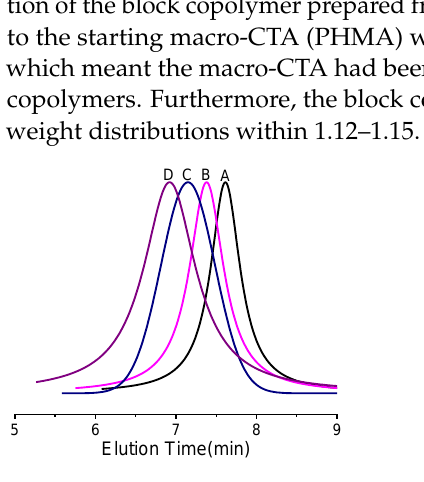
Figure 1. GPC curves of block copolymers (A) B1 (M n = 10,700 g mol −1 , M w /M n = 1.12); (B) B2 (M n = 15,150 g mol −1 , M w /M n = 1.13); (C) B3 (M n = 19,500 g mol −1 , M w /M n = 1.12); (D) B4 (M n = 27,300 g mol −1 , M w /M n =